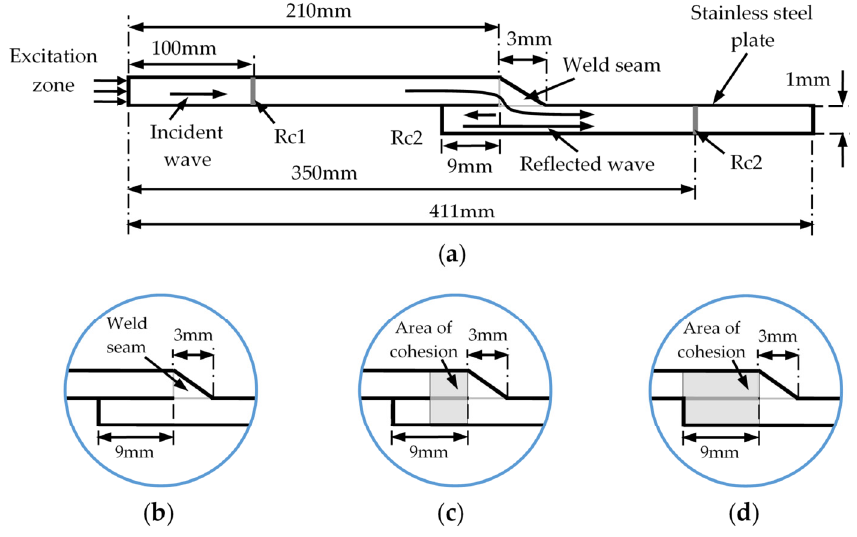
Figure 7. ( a ) Model used for the investigation of the symmetric S 0 wave mode propagation through the lap joint in the case of: ( b ) plates are connected only at the weld seam position; ( c ) partially bonded plates; ( d ) fully bonded